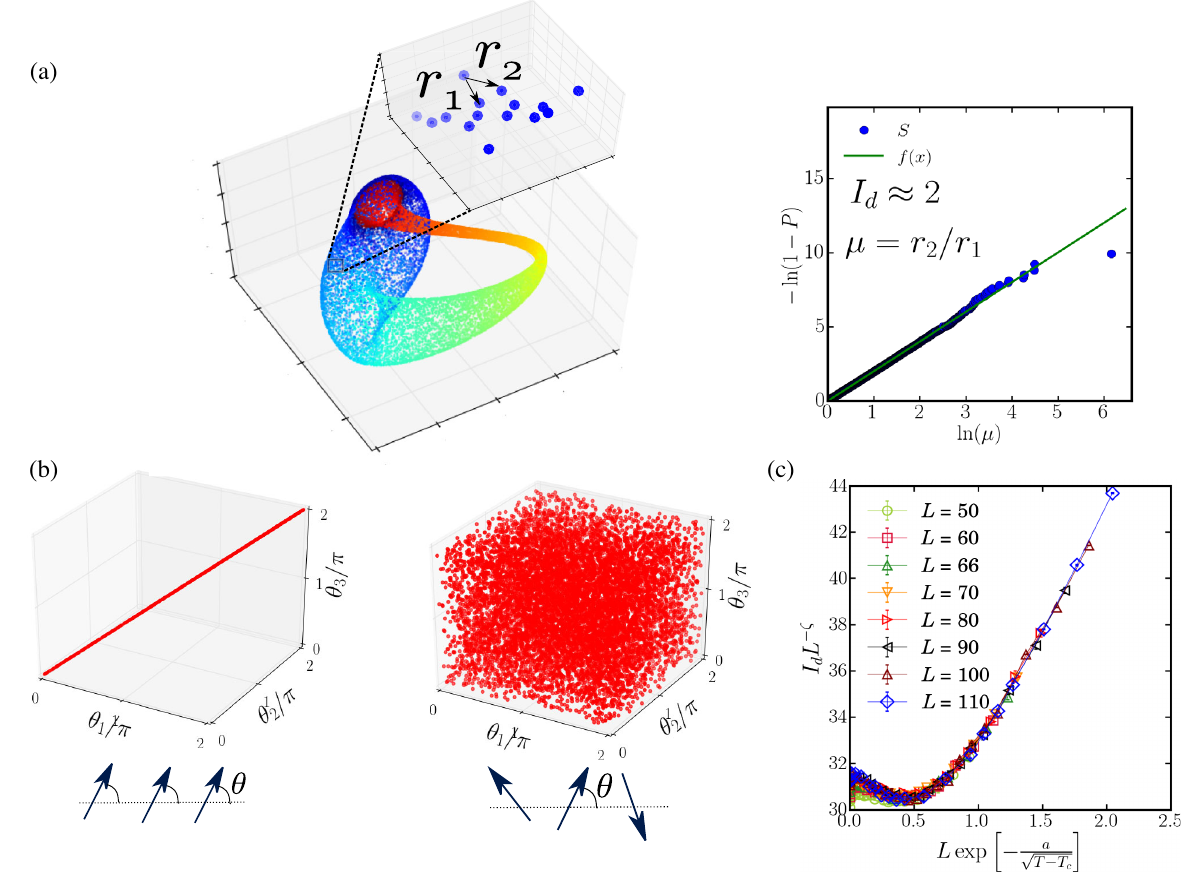
FIG. 1. (a) Schematics of the intrinsic dimension I d . The important content of a data set typically lies within a manifold whose I d is much lower than the number of coordinates. In the example, despite the fact that the synthetic data set (Klein ’ s bottle-shaped data set) is embedded in a three-dimensional space, it can be effectively described by a twisted manifold whose I d ¼ 2 . The key ingredients to compute the I d are the first- and the second-nearest-neighbor distances, r 1 and r 2 , of each point of the data set. The computation of the I d is based on the fitting of the empirical, cumulative distribution function (CDF) of the ratio μ ¼ r 2 =r 1 , P ð μ Þ [see text and Eq. (2)]. (b) Low- and high-temperature data sets of a three-site model in configuration space. The points represent the three-site XY model ⃗ θ configurations: ¼ ð θ 1 ; θ 2 ; θ 3 Þ . The high- and zero-temperature cases show simple data structures: For T ¼ 100 , I d is equal to the number of spins, while for T ¼ 0 , I d ¼ 1 . (c) Intrinsic dimension in the vicinity of a phase transition. The I d in the intermediate- temperature regime, representative of phase transitions in larger systems, is considerably more complex. The temperature dependence of I d can be used to locate and characterize critical points. As an example, we show the universal data collapse of the Kosterlitz-Thouless transition described by the 2D XY